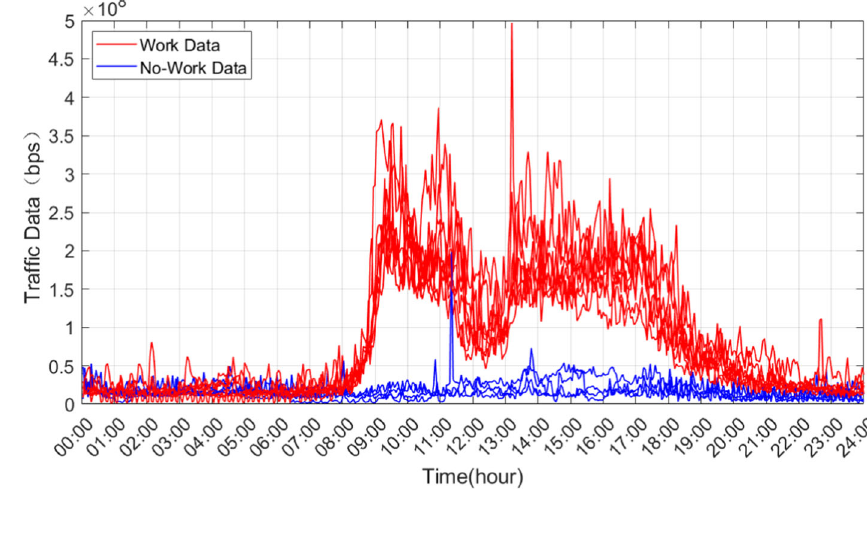
Fig. 3 The result of SDK means ??